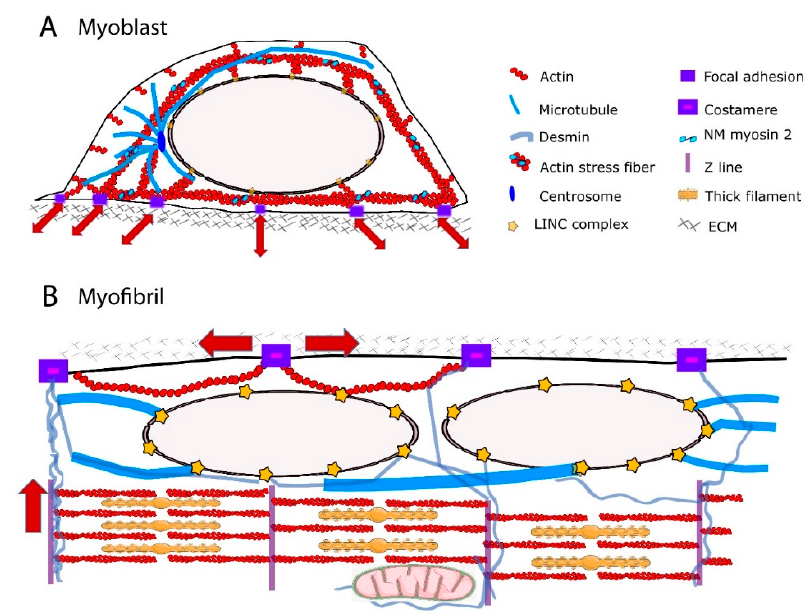
Figure 1. Schematic representation of cytoskeleton and force transmission in the myoblast and myofibril. ( A ) Radial distribution of the actin, microtubule and intermediate filament (IF) networks in myoblast favors the transmission of extra- and intra-cellular forces (red arrows) to the nucleus. Direct connections between focal adhesions and the actin cytoskeleton transmit the force along actin fibers towards the nucleus. Reciprocally, intracellular forces can be transmitted from the cell interior to the extracellular matrix (ECM). Perinuclear cytoskeleton is tethered to the nucleus via Linker of Nucleoskeleton and Cytoskeleton (LINC) complex. ( B ) Paraxial arrays of F-actin, microtubules and IFs in myofibrils. Main directions of force transmission from the contractile apparatus to the ECM are indicated (red arrows). In skeletal muscle, contractile force can be transmitted laterally between the z-disks of neighboring myofibrils to the ECM through specific cell–matrix adhesions called costameres.